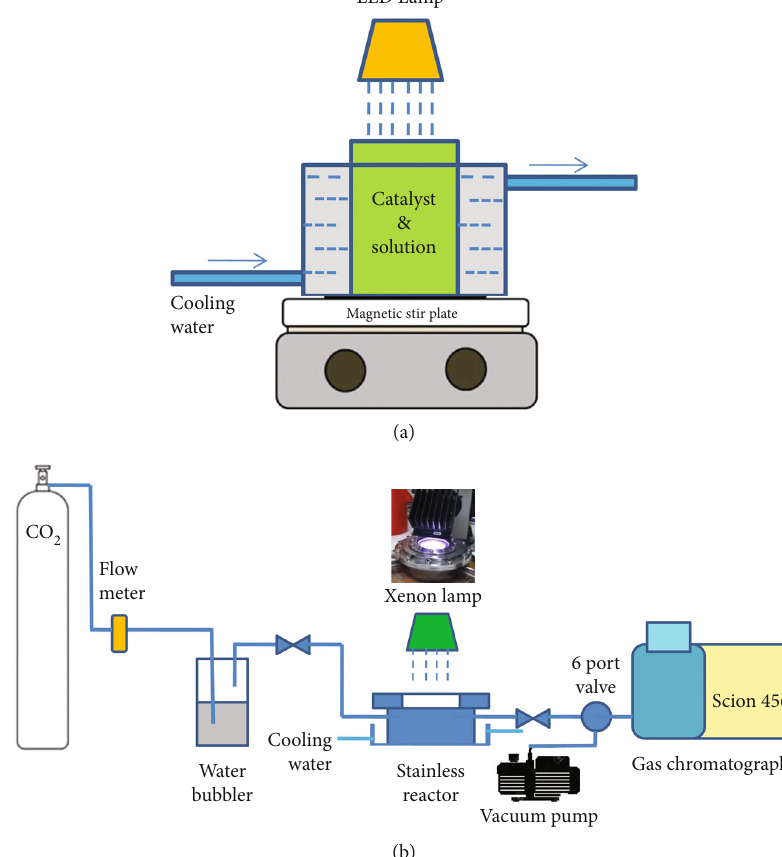
Figure 1: Scheme of the photocatalytic reactor used for OTC oxidation (a) and CO